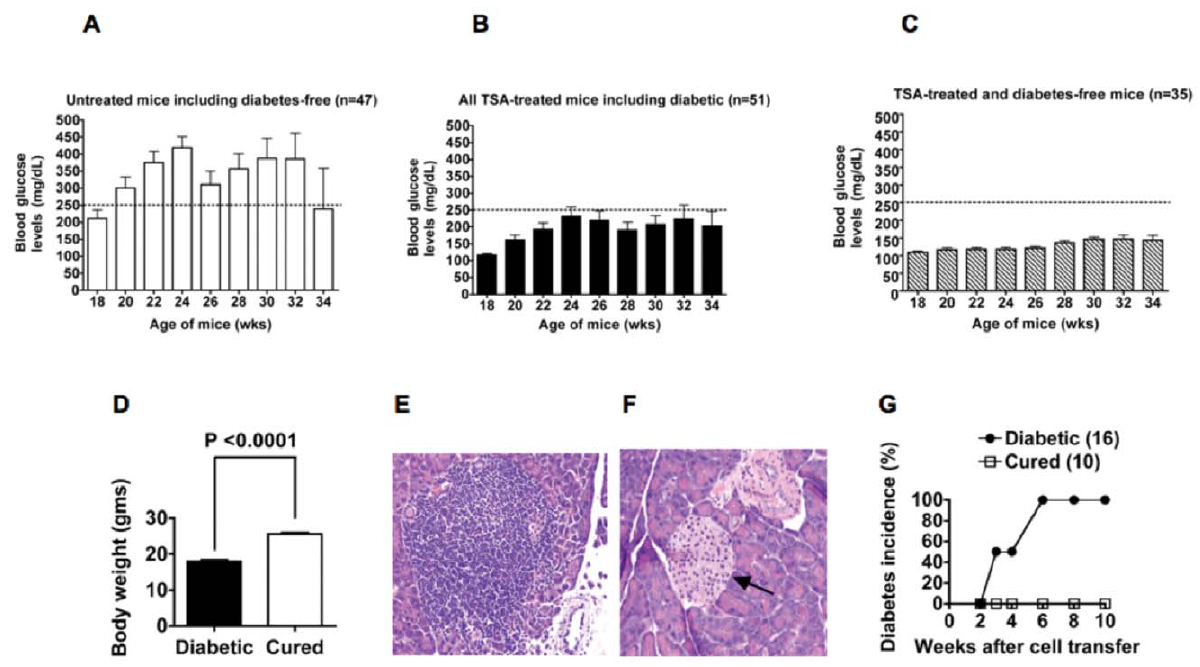
Figure 1. Epigenetic regulation of T1D. ( A ) The average blood glucose levels of 47 untreated female NOD mice are shown. Whereas a majority (80%) of untreated mice became diabetic ( . 250 mg/dL of blood glucose as indicated by the dotted line) when they reached . 18 wk of age, only a minority (20%) of untreated mice remained non-diabetic till the end of the observation period, 34 wk. This is reflected by the lower non-fasting blood glucose levels at 34 wk of age in the small number of untreated mice. ( B ) Glycemic profiles of female mice treated with TSA during 18–24 wk of age indicate that a vast majority (71%) of these mice was protected from diabetes. However, the overall average blood glucose levels of these mice appeared to be higher than those found in younger (18–20 wk old) mice. This was attributed to the inclusion of higher levels of glucose in 29% of diabetic mice also in the analysis. ( C ) Depiction of glucose levels in TSA-treated mice that remained diabetes-free. Note that the levels of non-fasting glucose levels of these mice were similar to those of younger (18–20 wk old), non-diabetic mice. ( D ) Shown are changes in body weight of acutely diabetic mice and those treated with TSA ( n =35) at the time of sacrifice (32–34 wk of age). ( E ) Pancreatic section from overtly diabetic mice shows heavy infiltration of islets (x 40 magnification, Hematoxylin & Eosin staining). ( F ) Pancreata of cured mice typically contain smaller islets (indicated by an arrow) adjacent to blood vessels without accompanying inflammation (x 40 magnification). ( G ) Splenocytes were harvested individually from acutely diabetic mice and those cured of diabetes and transferred into individual NOD. scid mice. Diabetes was monitored weekly and the numbers of mice investigated are shown in parentheses.